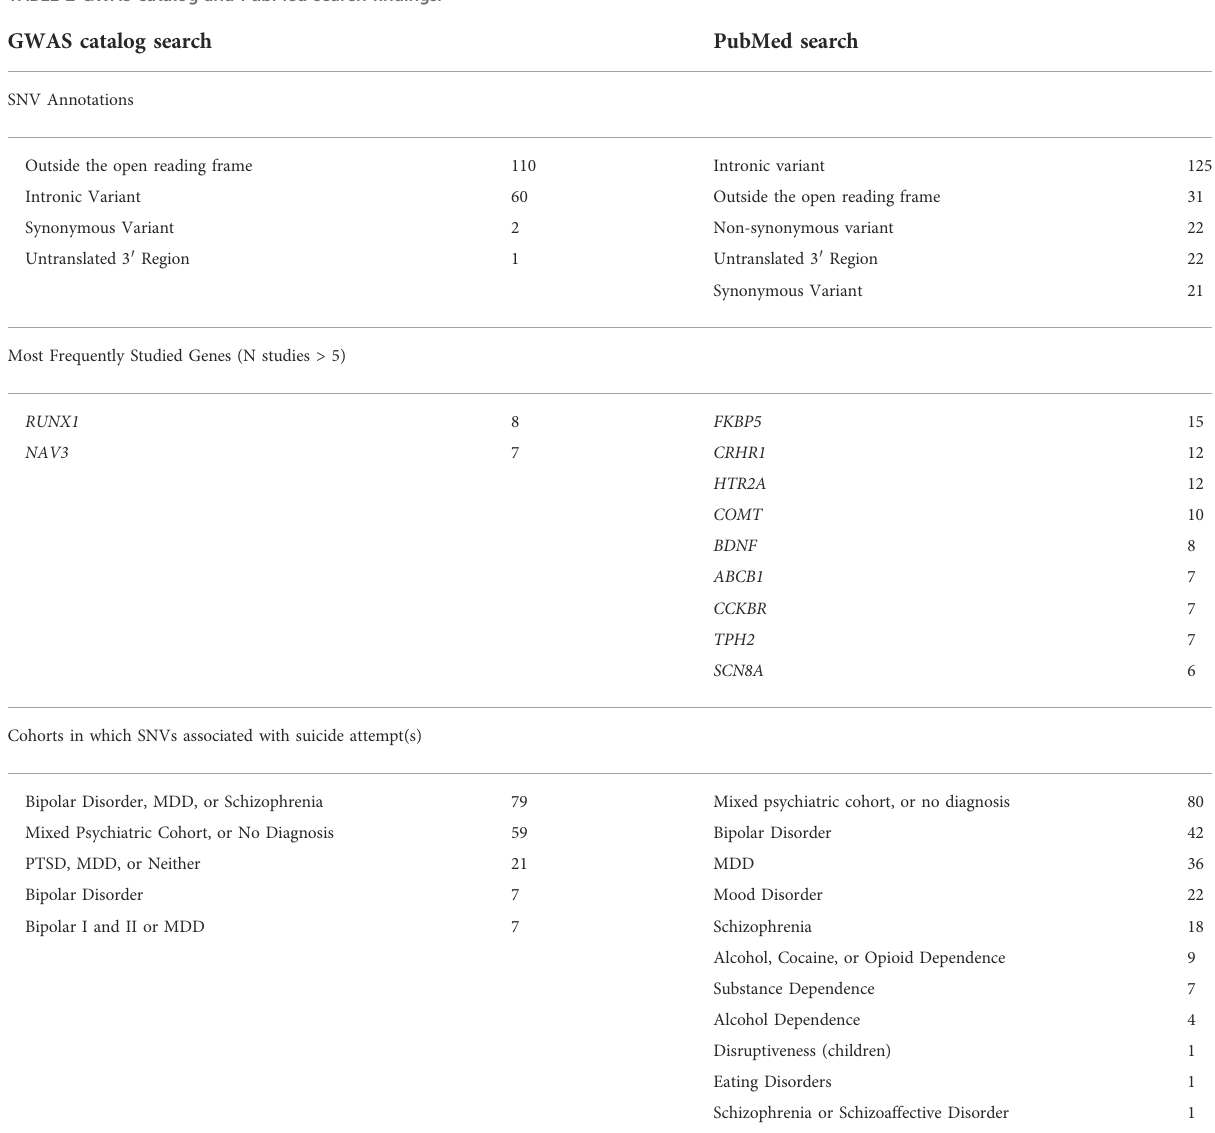
TABLE 2 GWAS catalog and PubMed search fi ndings.